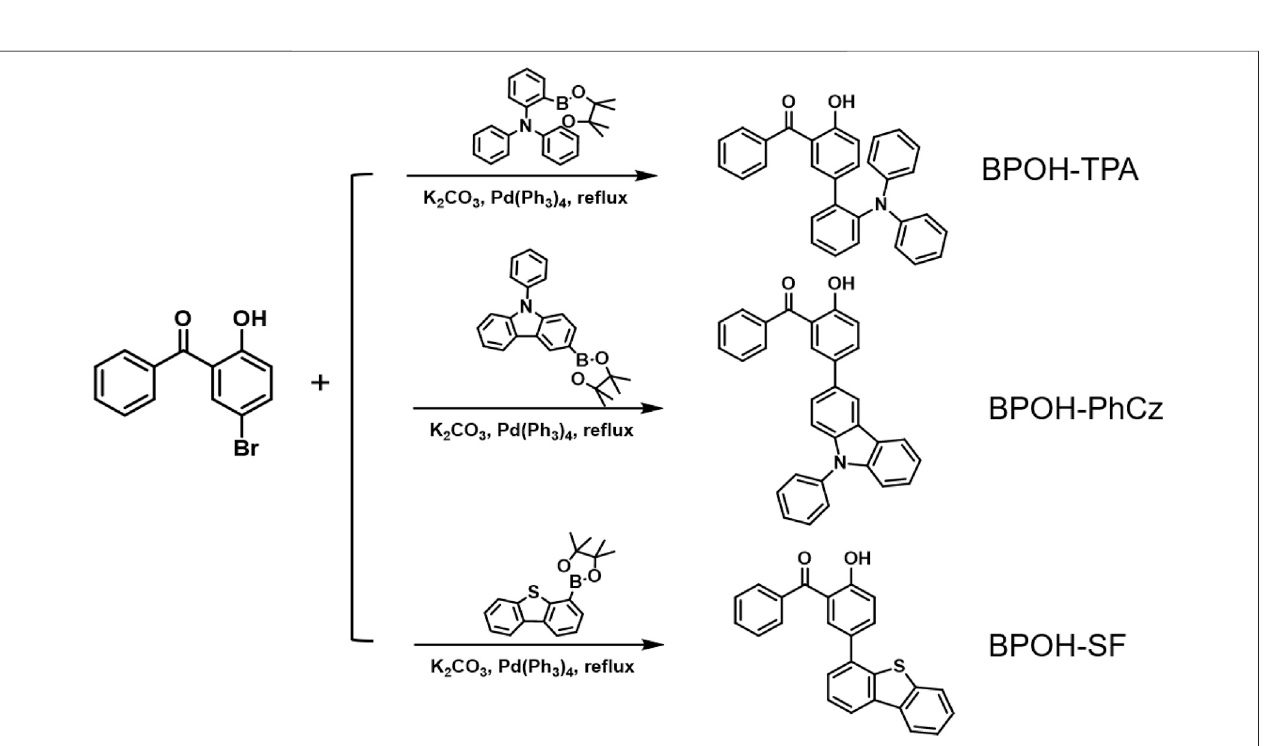
Frontiers in Chemistry |